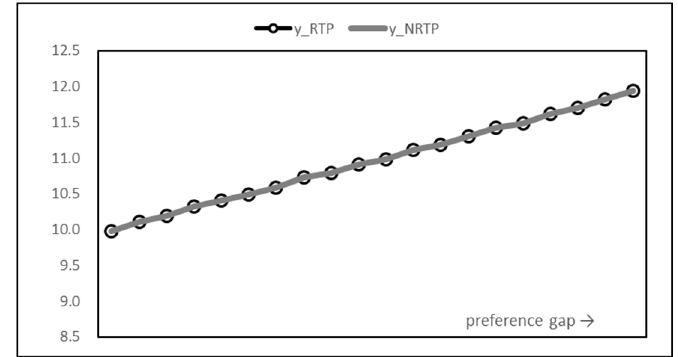
Figure 5. Total energy consumption graph.